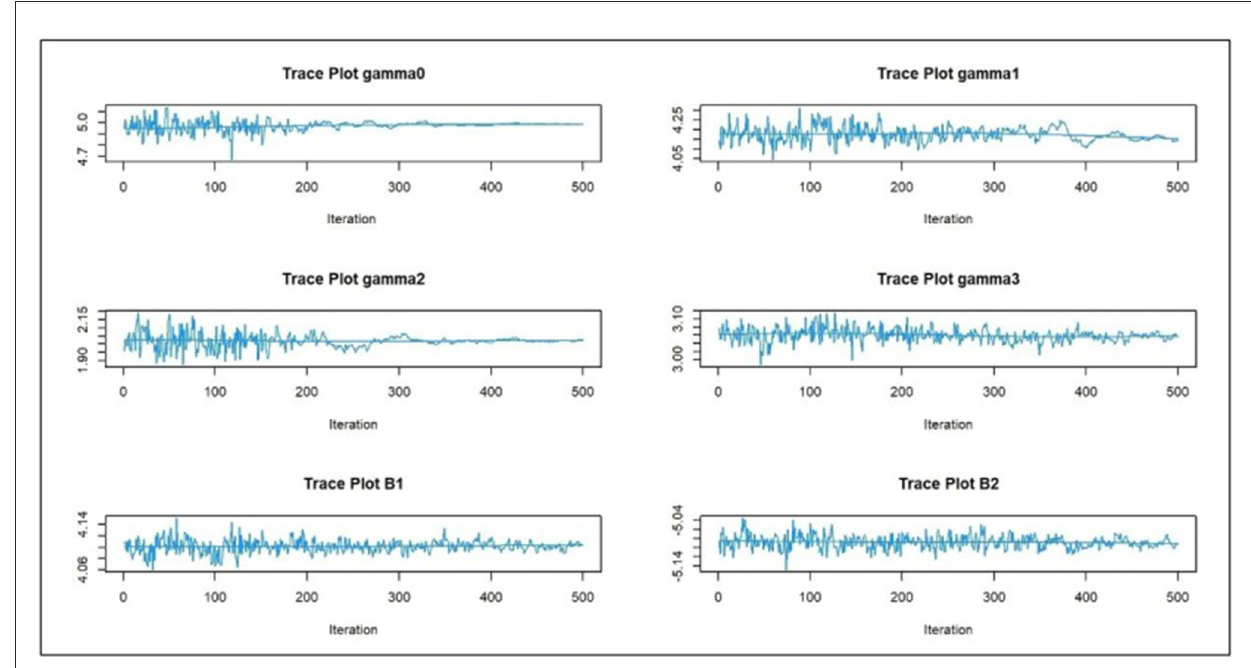
FIGURE1 Sample of the trace plot for the SAEM estimates ( n = 40), ε τ , ij ∼ ALD